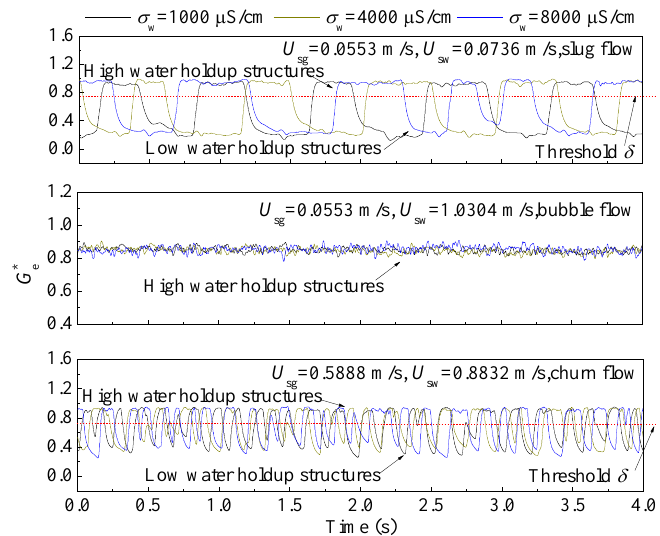
∗ Figure 8. The * e G of the water holdup sensor under different flow patterns and water conductivities. Figure 8. The G e of the water holdup sensor under di